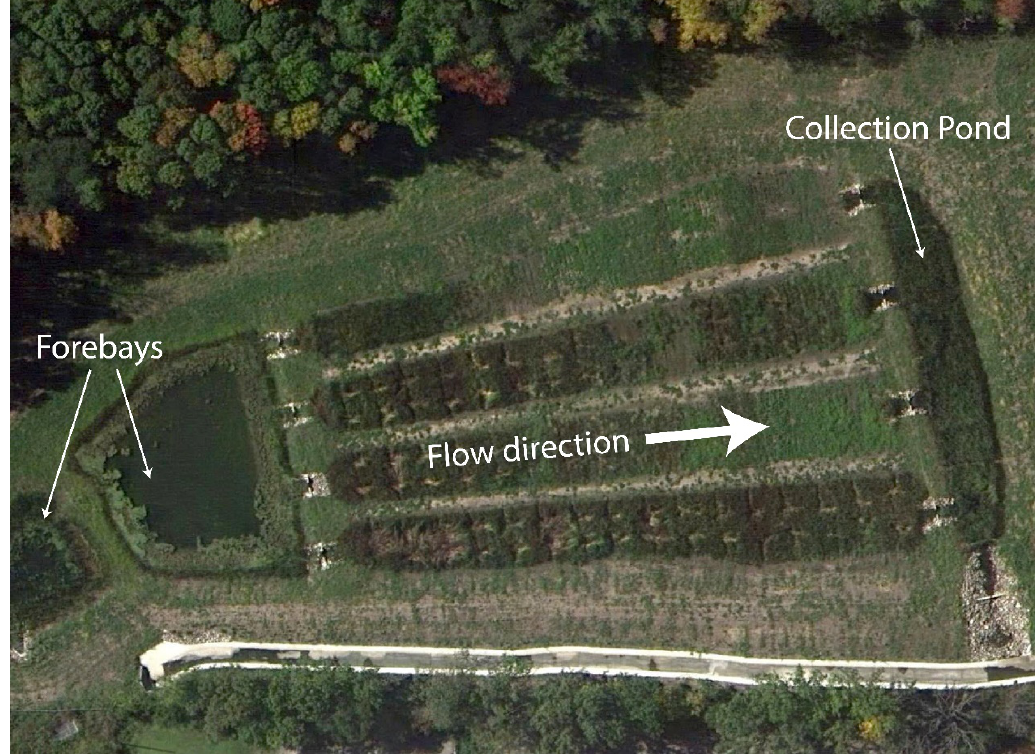
Figure 4. Urban runoff flows from left to right, into two forebays, then four swales, then into a collection pond that discharges to a concrete flume (bottom of photo). In between, four parallel swales were excavated, separated with berms, and surfaced with 15 cm of salvaged topsoil. Research occurred from 2010 to 2012, after which inflows were increased and outflows were decreased to retain more